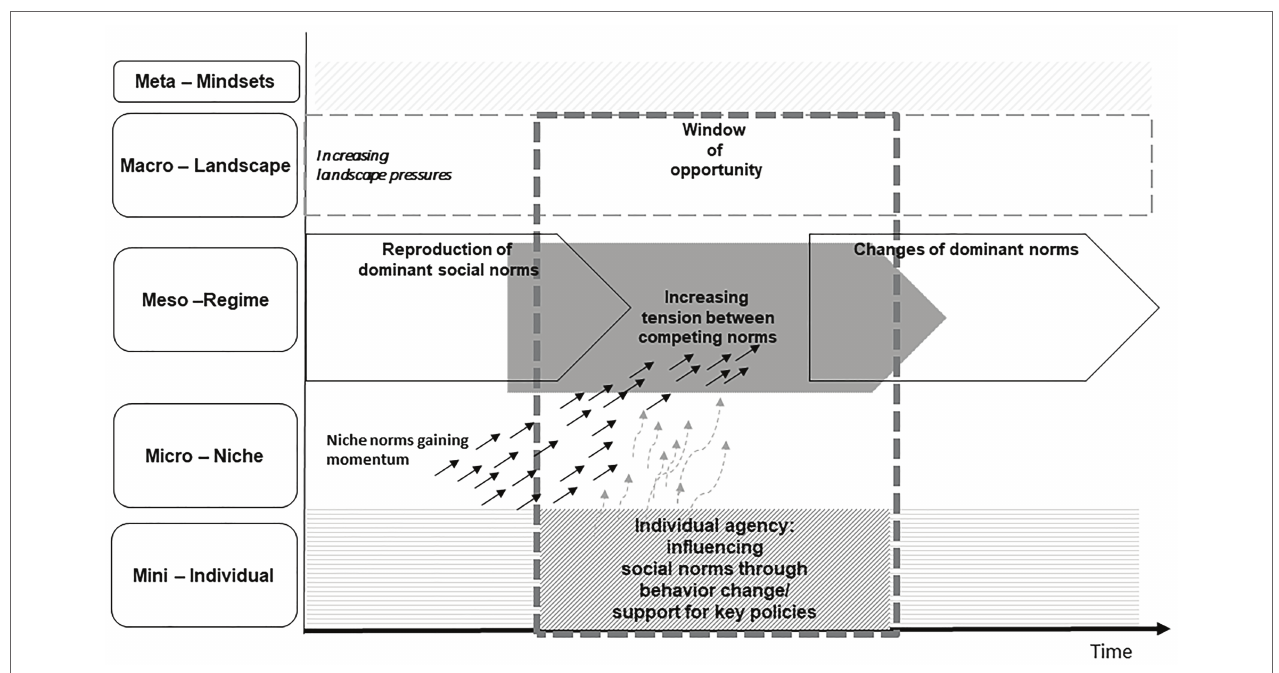
FIGURE 1 | Individual agency in the context of multi-level system dynamics (based on Göpel, 2016 and Geels et al.,